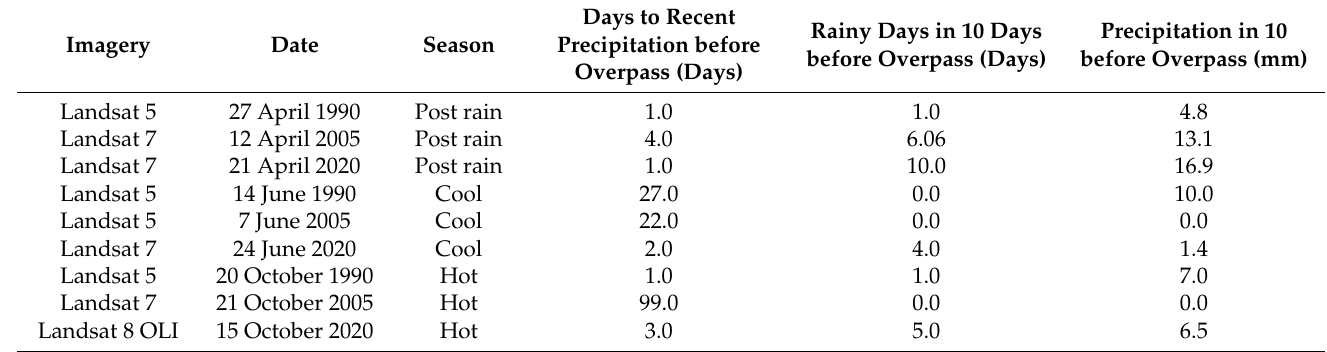
Table 1. Multi-temporal and multi-spectral remote sensing imagery used in the